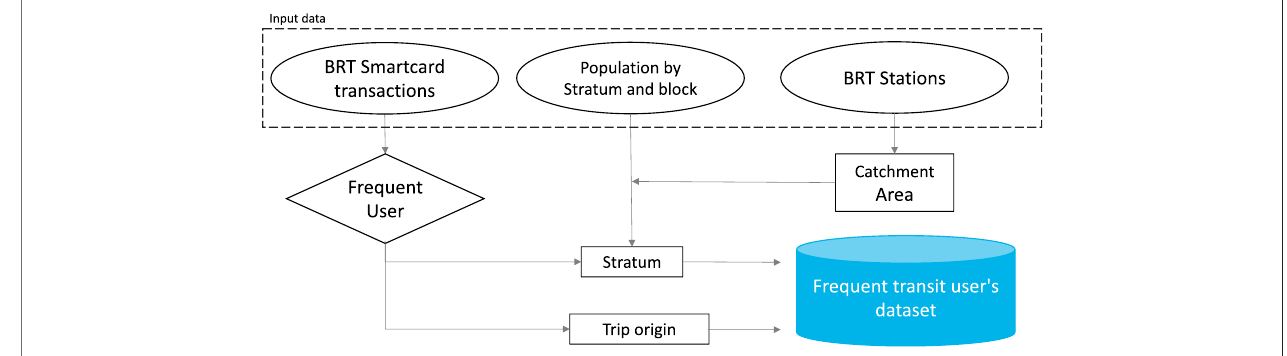
FIGURE 1 | Frequent transit users database development framework.